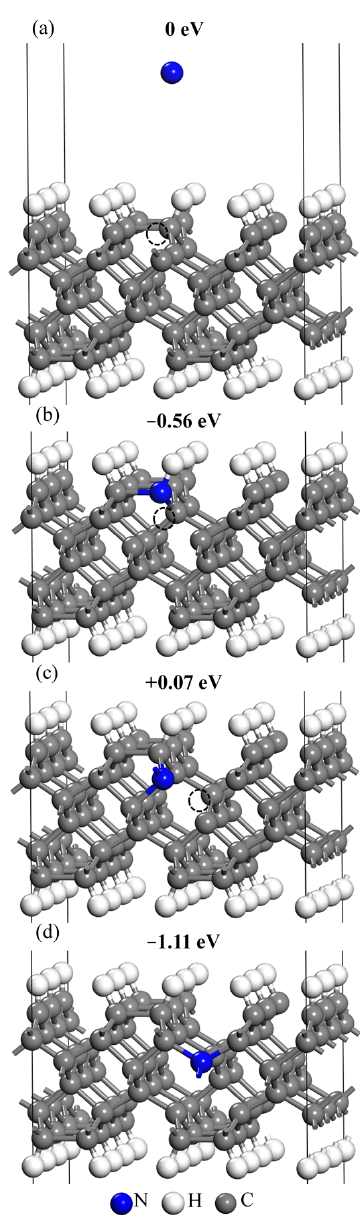
Figure 3. (Color online) ( a ) Nitrogen exposure and ( b ) chemisorption of a nitrogen atom on the diamond surface; nitrogen substitution on the ( c ) second and ( d ) third layers of the diamond surface. The stoichiometry of all super cells was fixed at C 71 H 23 N 1 . Blue, white, and gray spheres represent N, H, and C atoms, respectively. Dashed circles indicate vacancies.